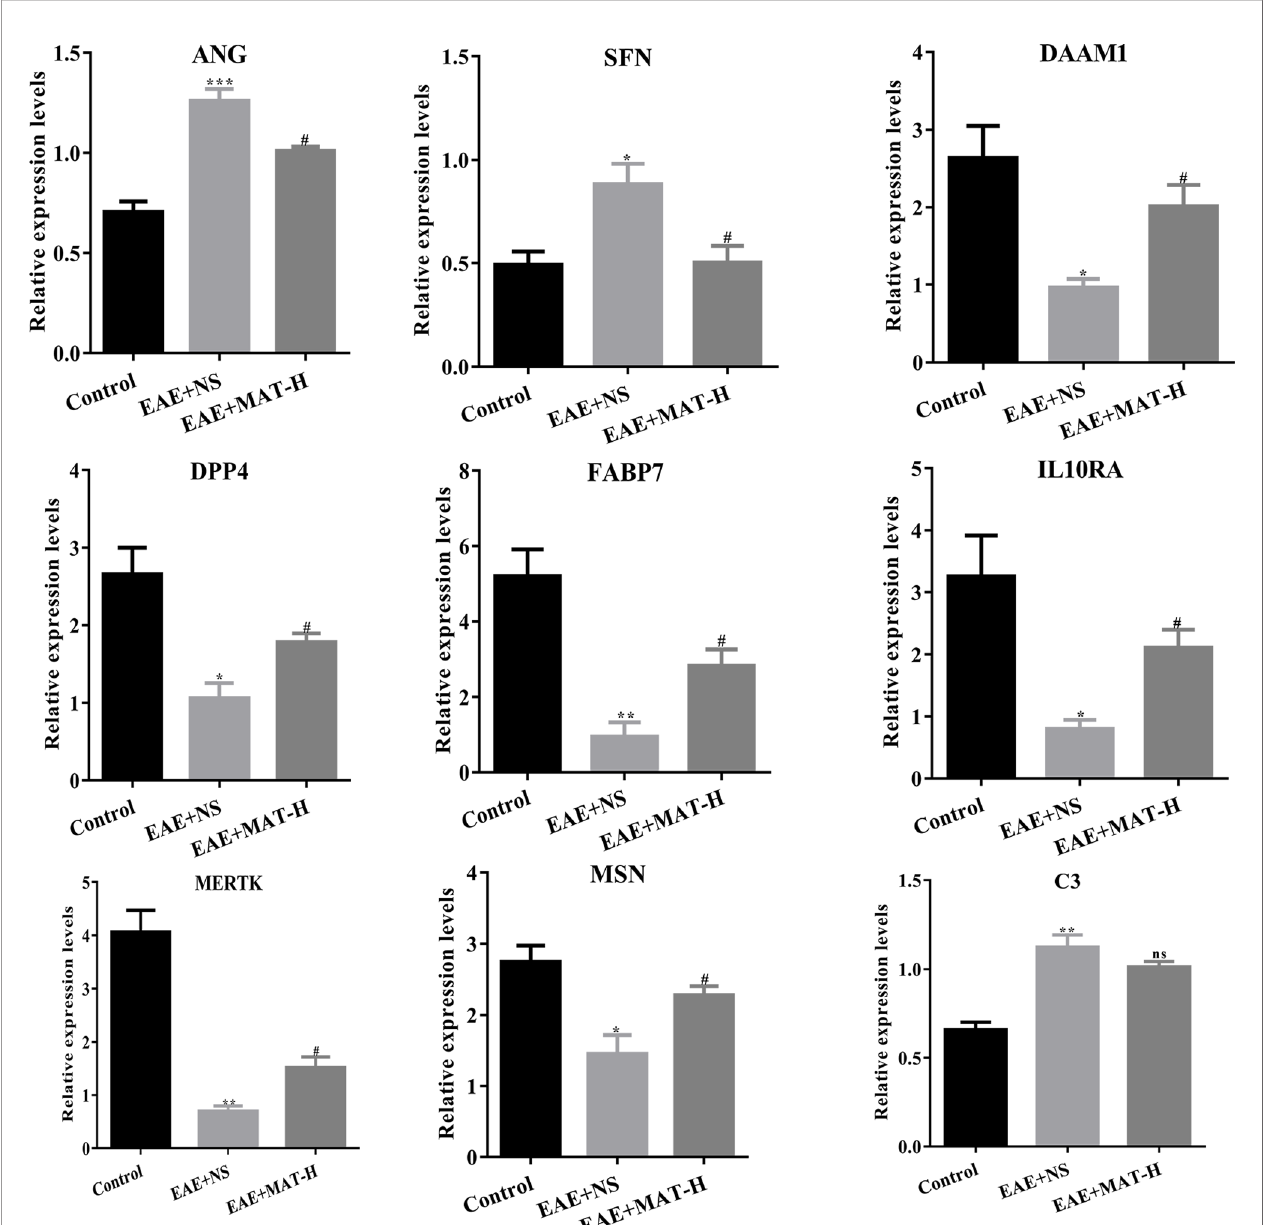
FIGURE 7 | The relative expression of key genes by qPCR. ANG, SFN, DAAM1, DPP4, FABP7, IL10RA, MERTK, MSN and C3 of naïve control, EAE+NS, EAE+MAT-H groups. On day 23 p.i., the brain tissues of mice were harvested after heart perfusion. qPCR was used to evaluate the relative expression levels of key genes in each group. *, ** or *** represents the comparison between naïve control and EAE+NS groups, and # represents the comparison between EAE+NS and EAE+MAT-H groups. Data are shown as mean ± SD (n=6 in Control, n=10 in each EAE group). *or # P < 0.05; ** P < 0.01; *** P < 0.001. ns, not signi fi